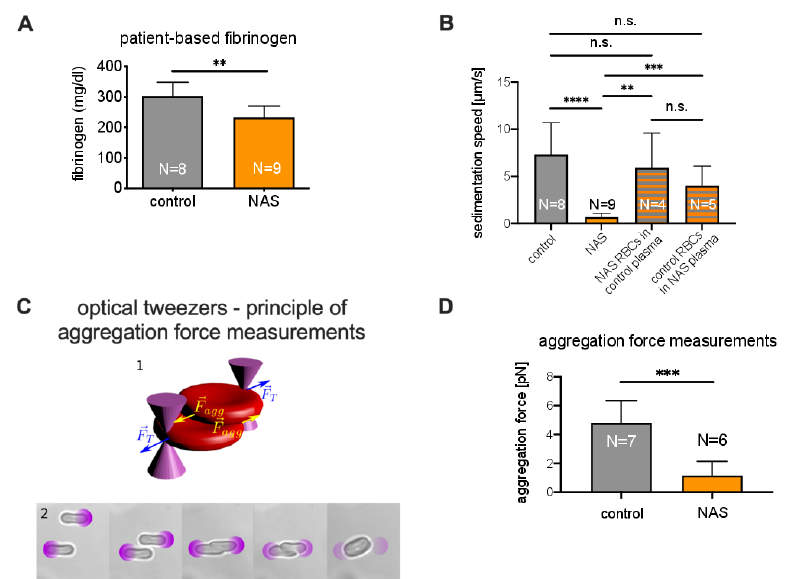
Figure 5. Measurements related to the role of plasma in sedimentation. ( A ): Comparison of fibrinogen concentrations. A significant difference consistent with the aggregation force difference was observed. ( B ): Comparison of sedimentation velocities of control samples, NAS patient samples, and samples with erythrocytes and plasma exchanged. ( C ) 1: Schematic of the forces acting on the erythrocytes trapped in optical tweezers. ( C ) 2: Microphotographs of the protocol for the measurement of the aggregating force. The purple circles show the locations of external optical traps. From left to right: